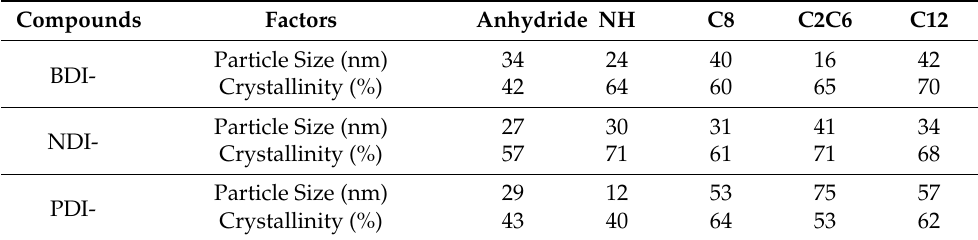
Table 2. Particle size and crystallinity for BDI-, NDI-, and PDI-based